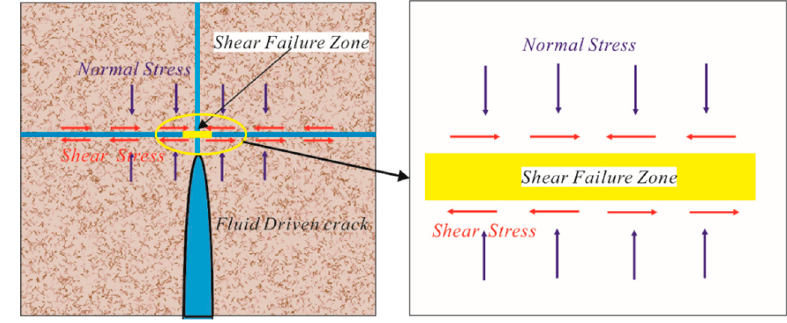
Figure 12. Shear model of interface.